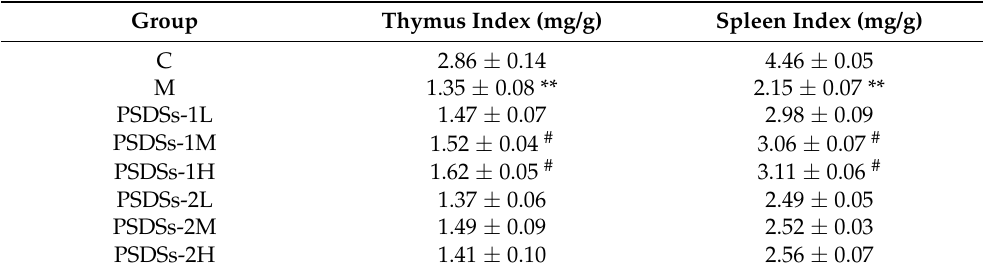
Table 2. Effect of PSDSs with different Mws on the immune organ index of mice. Group Thymus Index (mg/g)